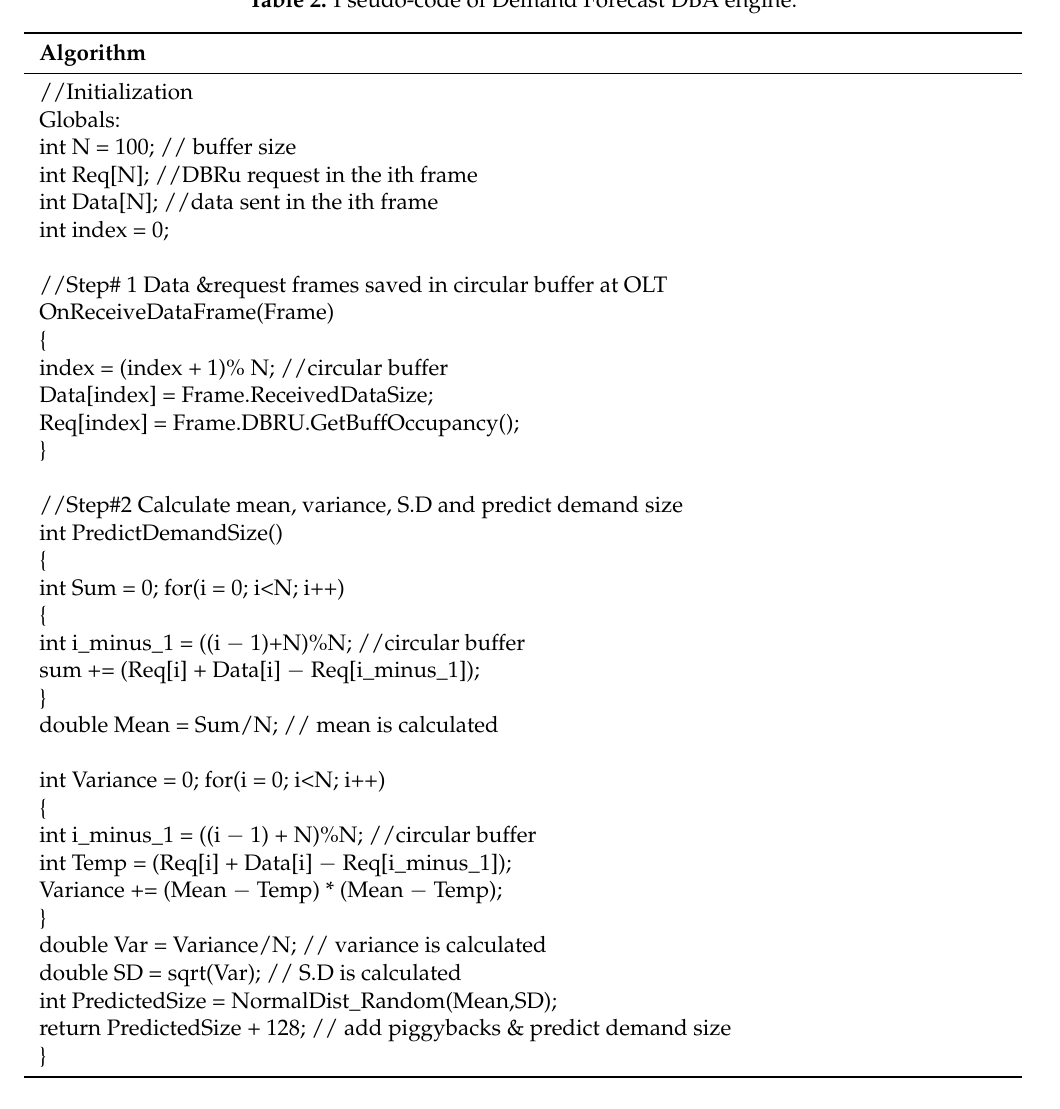
Table 2. Pseudo-code of Demand Forecast DBA